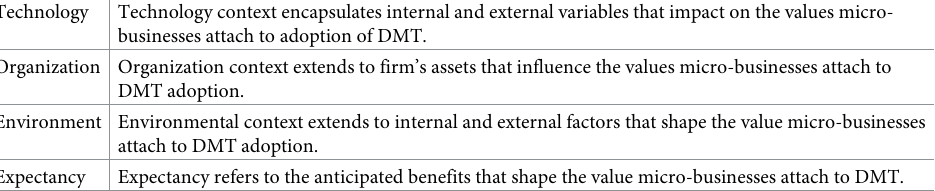
Table 3. Description of